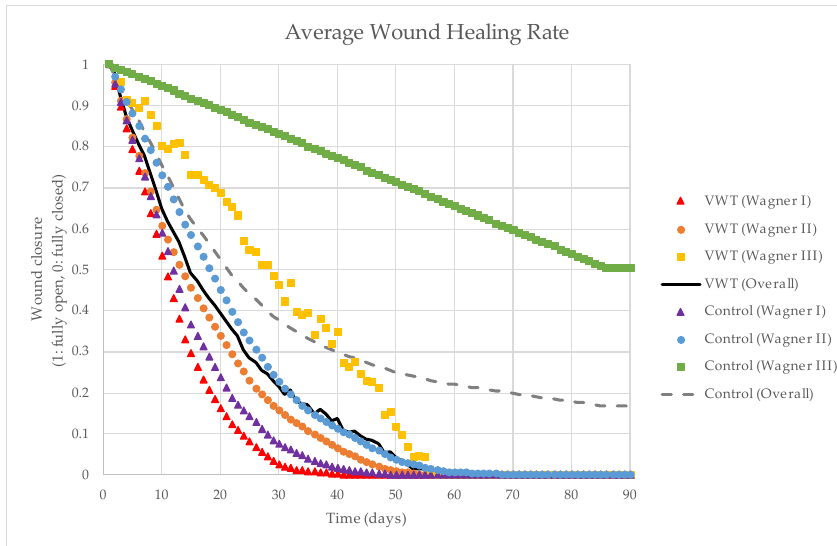
Table 5. Differences in NO levels between and within groups, before and after the intervention.